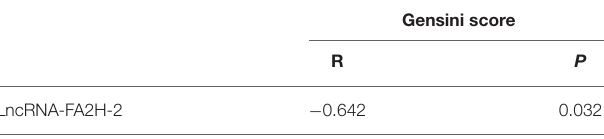
TABLE 9 | Correlation analysis of the Gensini score and LncRNA-FA2H-2.